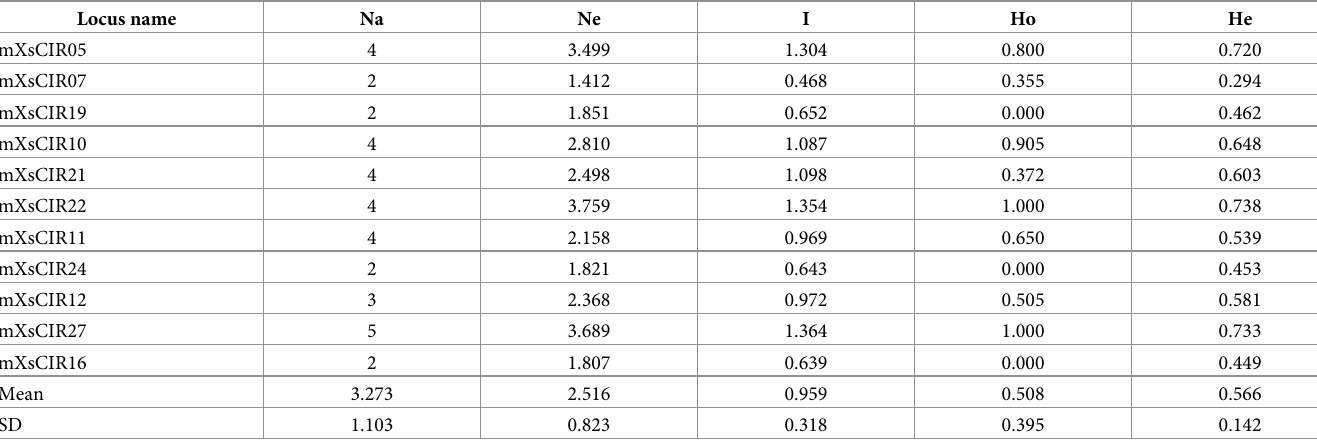
Table 3. Genetic diversity parameters in 100 cocoyam accessions.